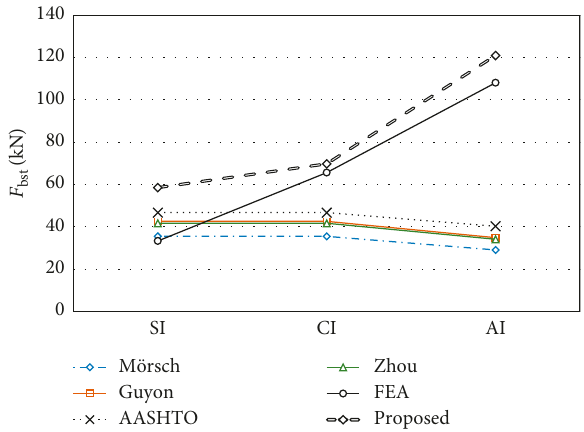
Figure 13: Evaluation of the proposed equation on the eccentric distance.